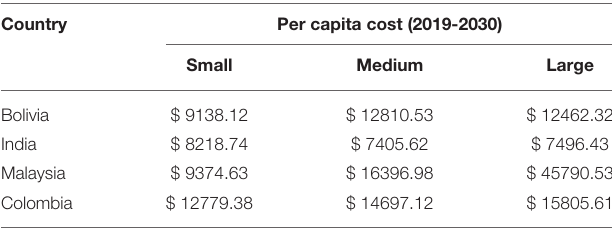
TABLE 3 | Average total cost estimates per capita by city size. Country Per capita cost (2019-2030) Small Medium